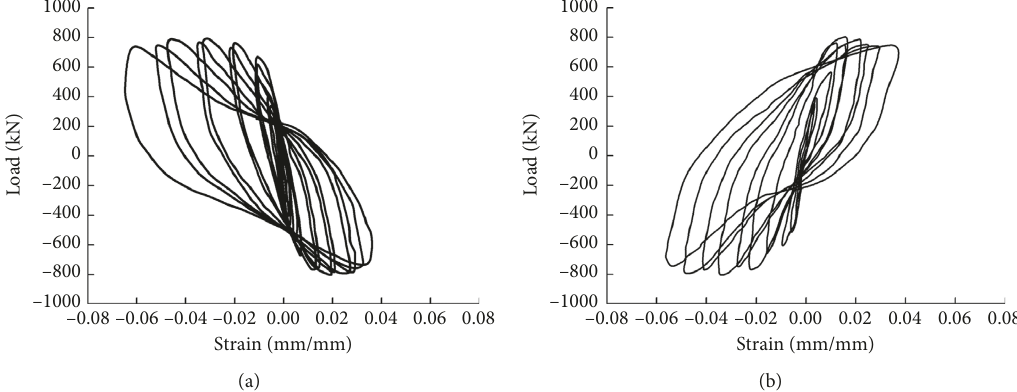
Figure 11: Strain of specimens. (a) Left edge strain. (b) Right edge strain.